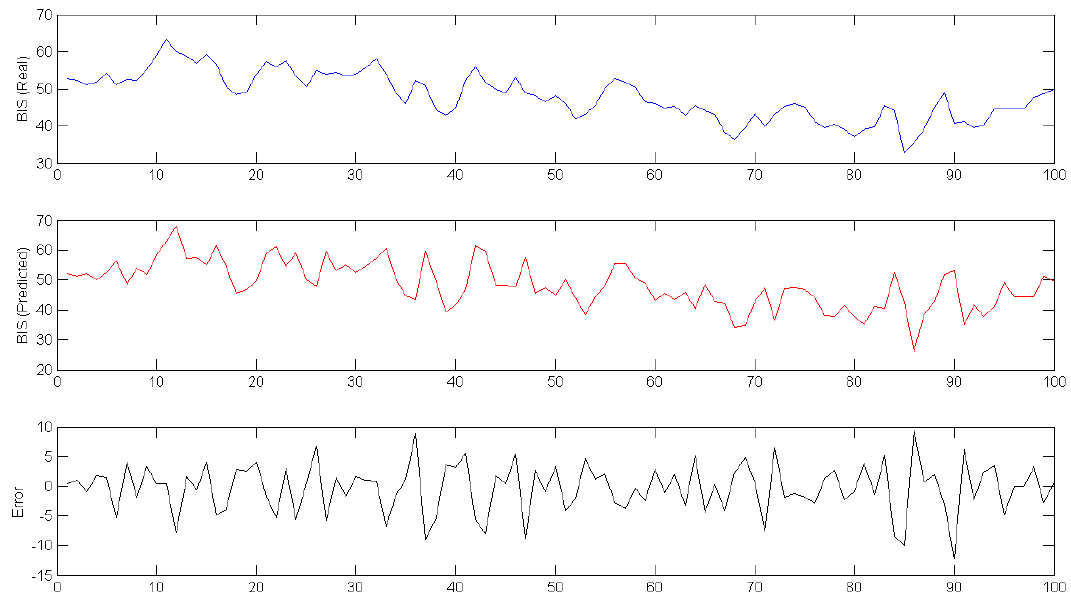
Figure 7. Real ( Top ); Predicted ( Middle ); and Error ( Bottom ) BIS signal for 100 samples during surgery.